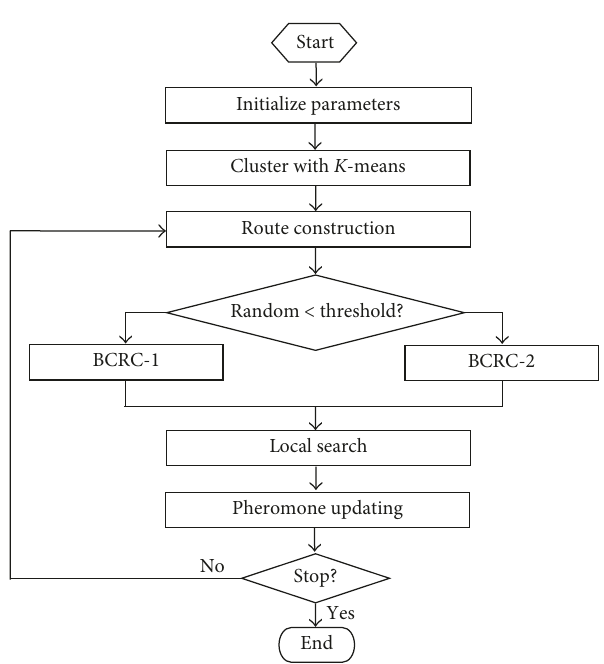
Figure 3: The flow chart of